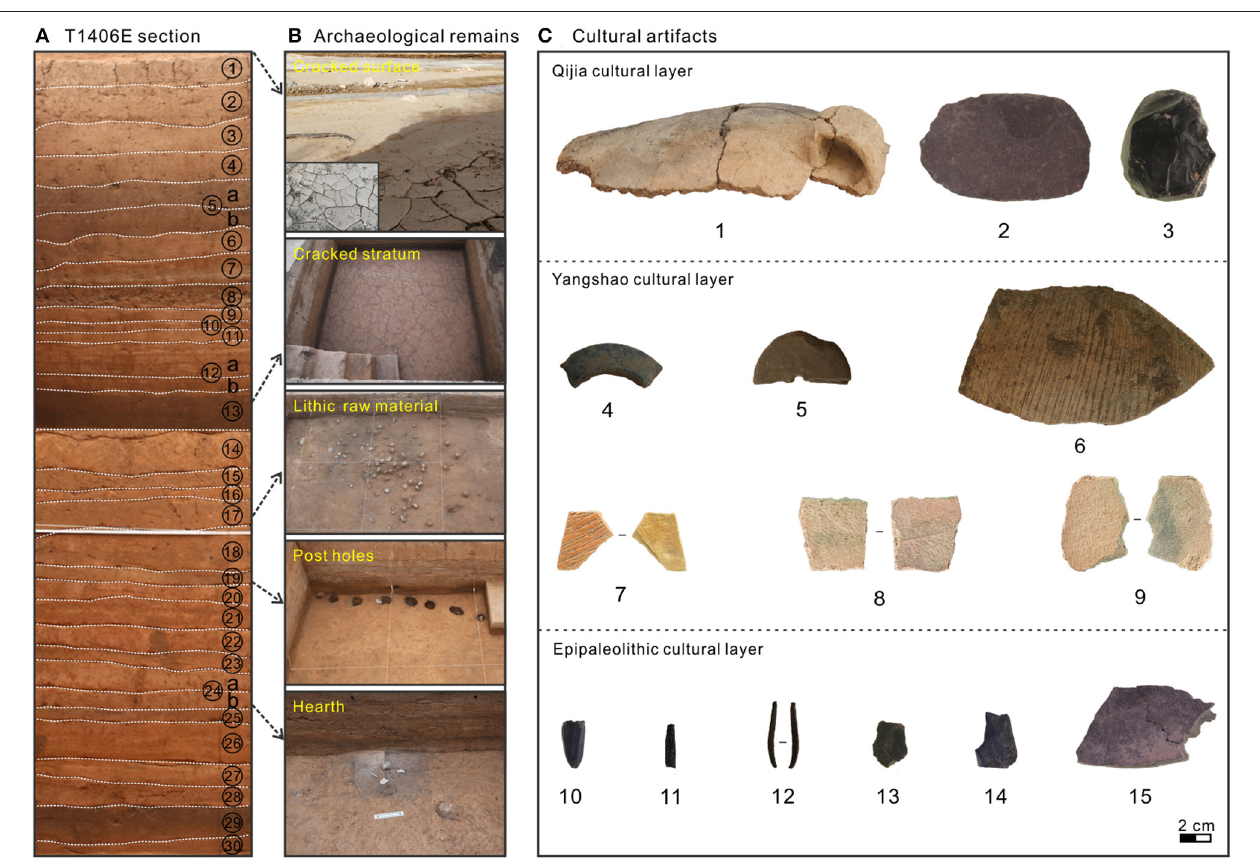
FIGURE 2 | Section T1406E at Shalongka (SLK) site and typical archaeological remains and cultural artifacts from the site. (A) Photo of the T1406 sampling section with stratigraphic layers numbered. (B) Typical archaeological remains unearthed in different layers of the SLK site. (C) Typical cultural artifacts unearthed in different layers of the SLK site. 1. Pottery jar fragments; 2. Stone knife; 3. Core; 4. Stone ring; 5. Spinning wheel; 6–9. Yangshao cultural pottery (7: SLK-1, 8: SLK − 2 and 9: SLK-3 were used for OSL dating); 10. Microblade core; 11–12. Microblades; 13: Flake; 14–15: Fragment and